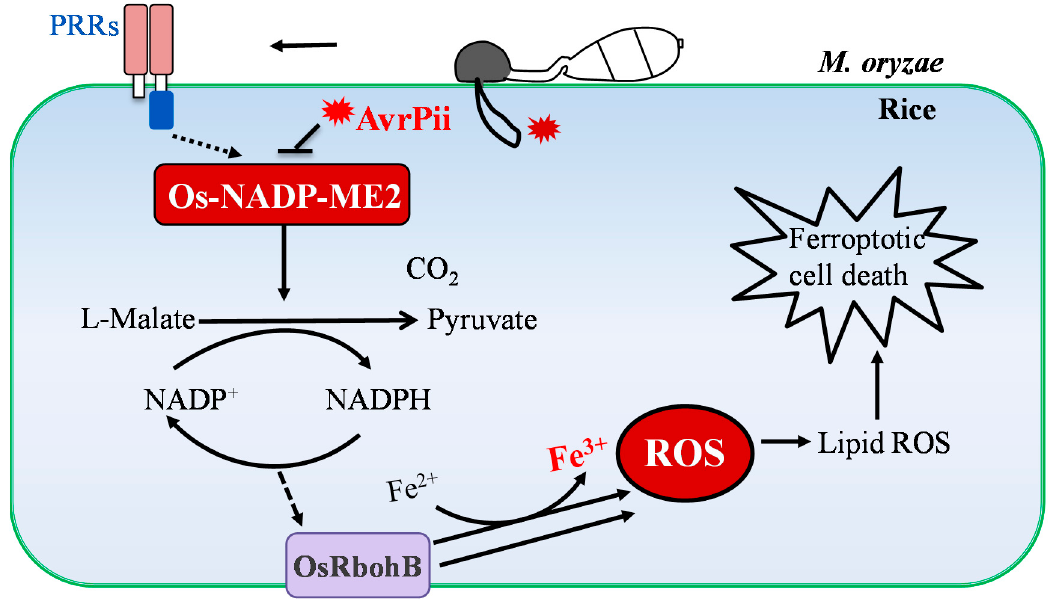
Figure 4. NADP-malic enzyme 2 regulates ROS production during M. oryzae infection. Os-NADP- ME2 is involved in the AvrPii-triggered ROS inhibition, chitin-triggered ROS burst, and ROS- dependent ferroptotic cell death. The malic enzyme activity of Os-NADP-ME2 is activated by chitin- treatment, while it can be suppressed by AvrPii. The activated Os-NADP-ME2 catalyzes malic acid acid, which generates NADPH, and subsequently produces ROS to induce the ROS-dependent into pyruvic acid, which generates NADPH, and subsequently produces ROS to induce the ROS- ferroptotic cell death in dependent ferroptotic cell death in rice.